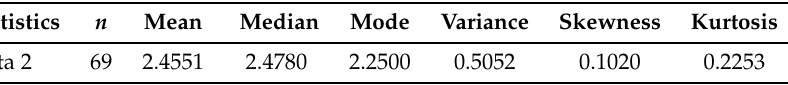
Table 6. Descriptive statistics for data set 2.